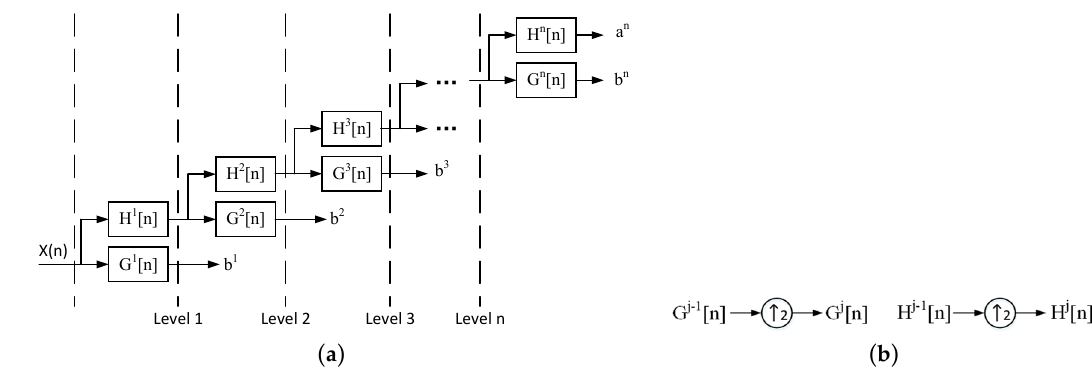
Figure 1. ( a ) Stationary Wavelet Transform (SWT) decomposition tree. ( b ) SWT filters.